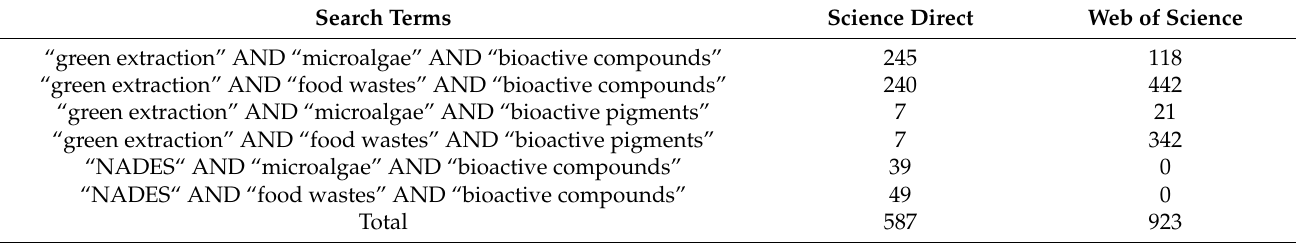
Table 1. Summary of keywords/search terms used in the Science Direct database and the results